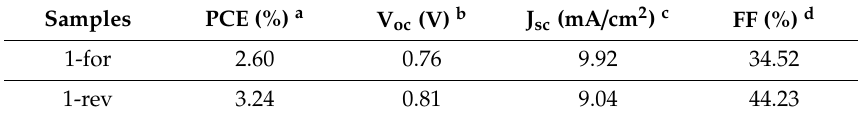
Figure 6. J–V curve of flexible perovskite solar cell. Table 2. Performance parameters of flexible perovskite solar cell. Table 2. Performance parameters of flexible perovskite solar cell.